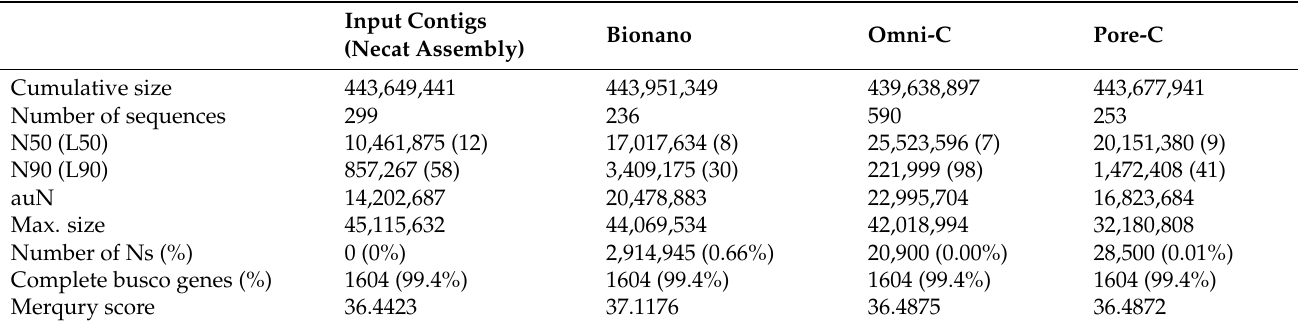
Table 1. Metrics of scaffolds generated by using only one scaffolding technology, compared to input contigs. Statistics were generated using sequences of more than 30 kb in